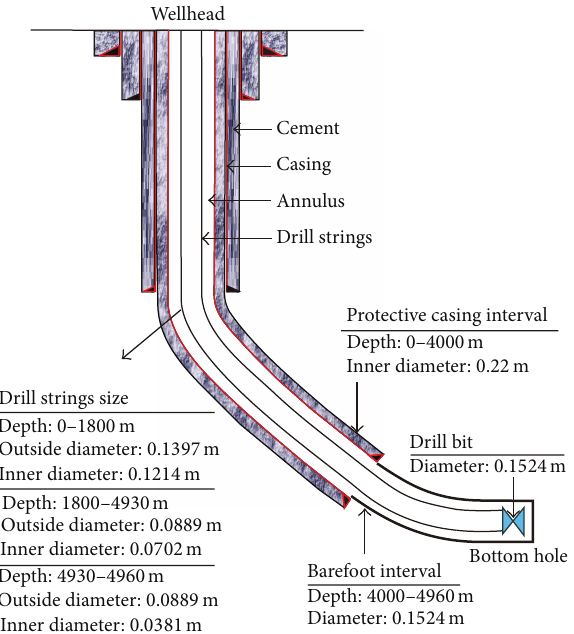
Figure 5: The hole geometry and drilling assembly of the well.